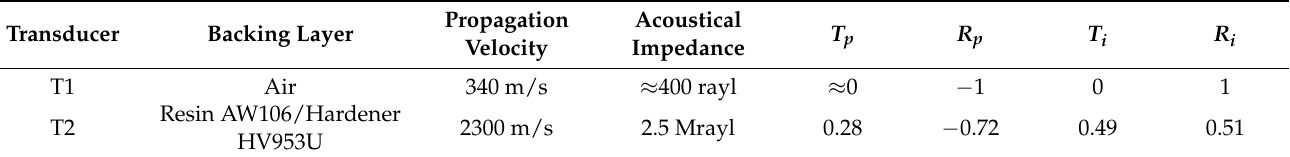
Table 2. Properties and coefficients of the backing layers calculated relatives to the 1–3 piezocomposite element. Transducer Backing